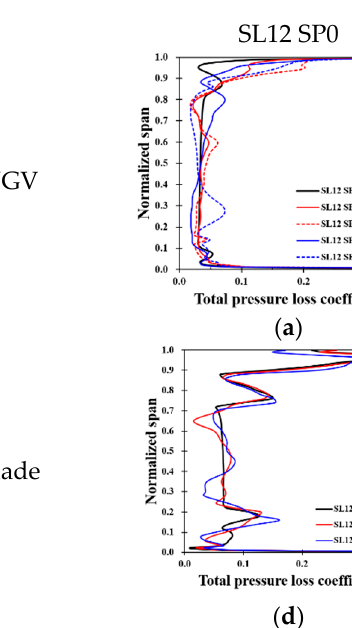
Figure 29. Comparison of circumferentially averaged mass flow rate, exit flow angle, and total pressure loss coefficient due to swirl clocking: ( a ) SL12 SP0—NGV; ( b ) SL − 12 SP0—NGV; ( c ) SL − 12 SP10—NGV; ( d ) SL12 SP0—Blade; ( e ) SL − 12 SP0—Blade; ( f ) SL − 12 SP10—Blade.